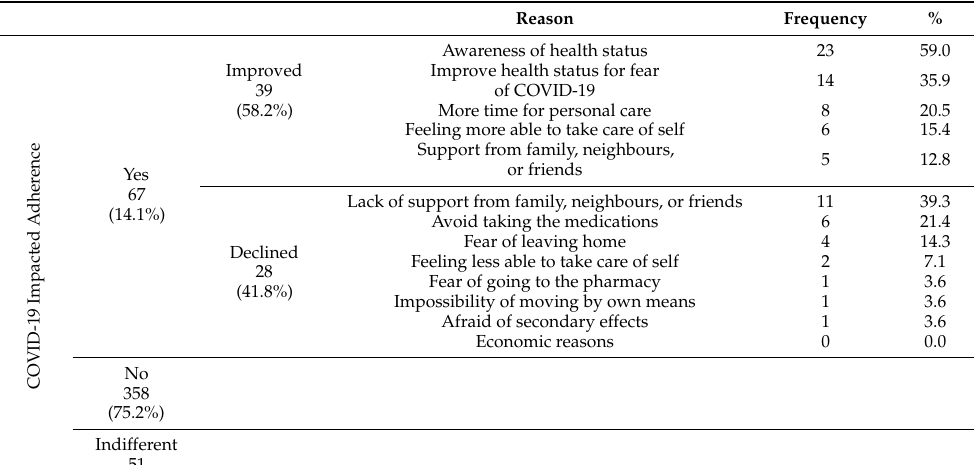
Table 2. Impact of the COVID-19 pandemic situation on the adherence